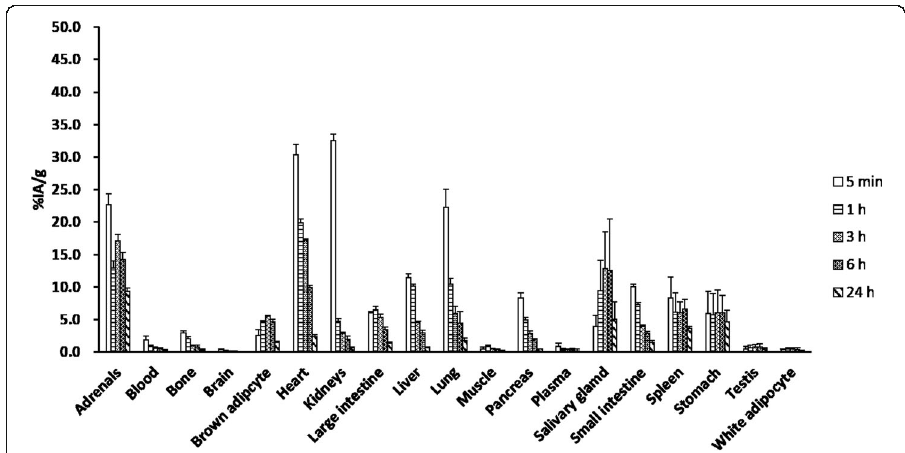
Fig. 2 Biodistribution data of 211 At-MABG in mice at 5 min, and at 1, 3, 6, and 24 h. Results are shown as %IA/g (mean ±